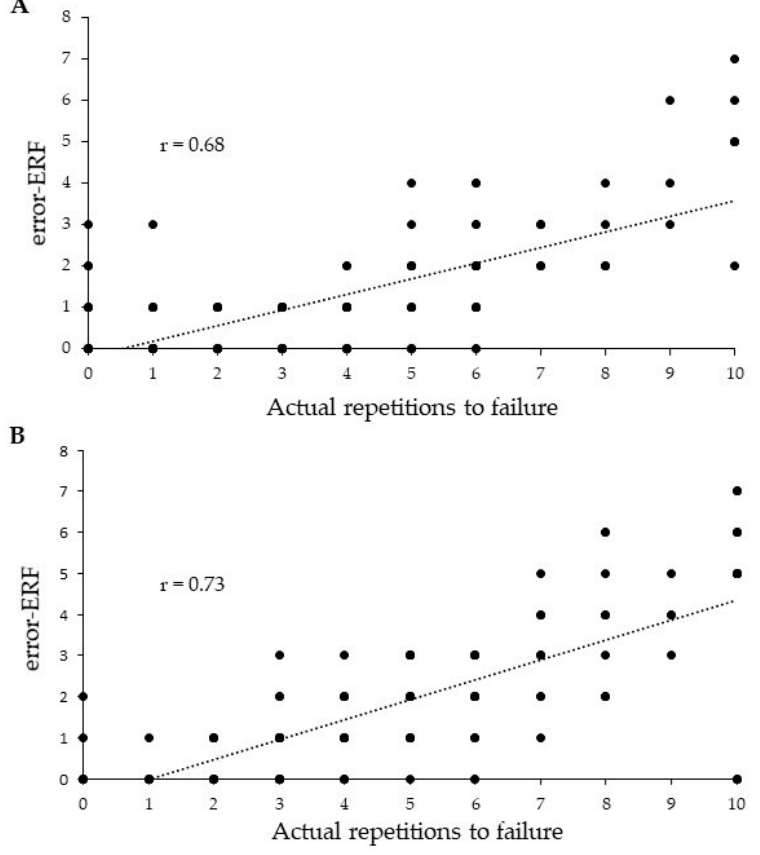
Figure 1. Scatter plot showing the association between error-estimated repetitions to failure (error-ERF) and actual repetitions to failure for the chest press ( A ) and leg press ( B ).